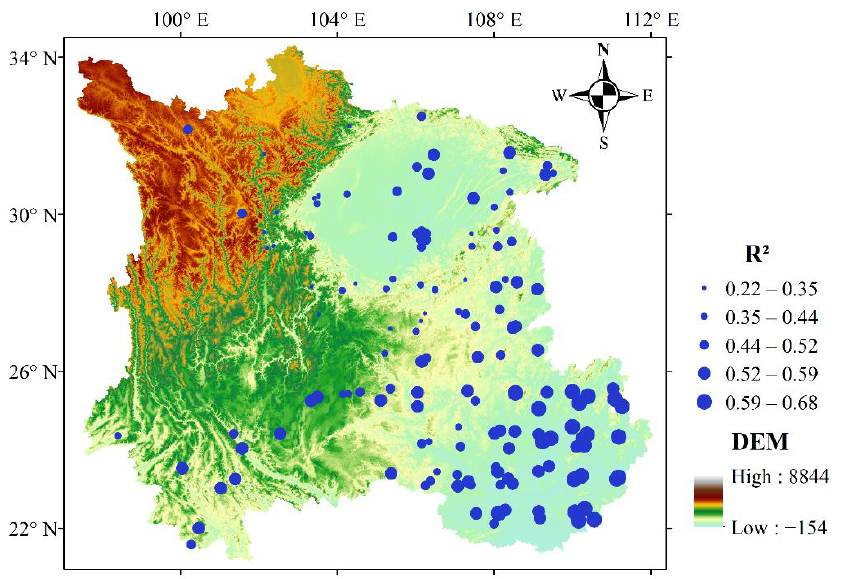
Figure 6. Spatial distribution of coefficient of determination (R 2 ) between the downscaled SPEI and in-situ SPEI at each meteorological station.